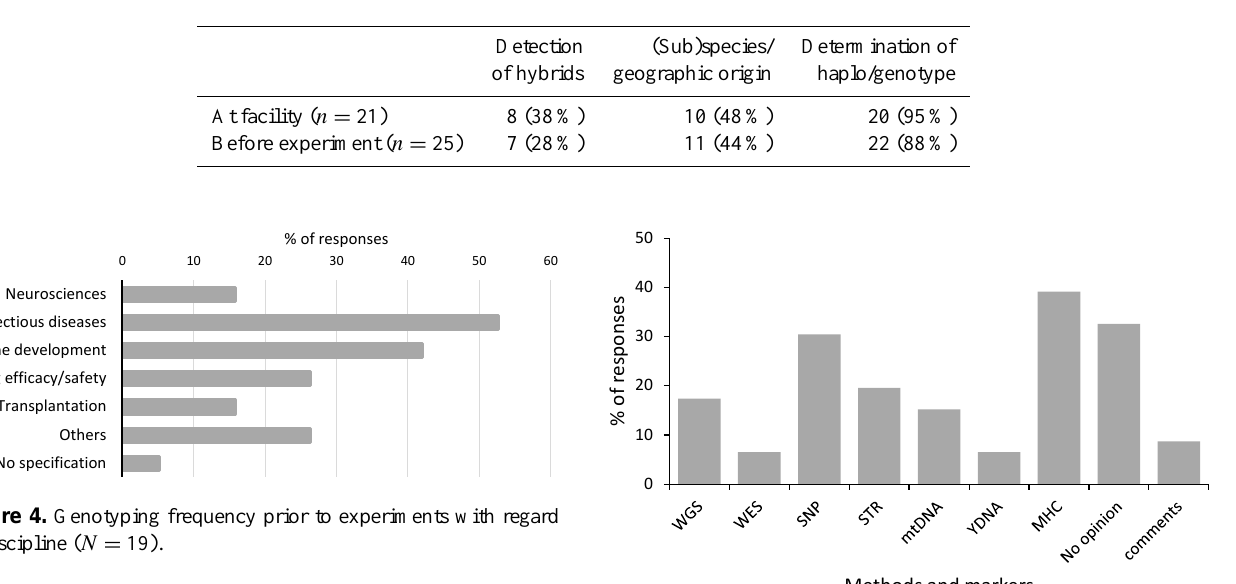
Table 2. Objectives for conducting genotyping at represented facilities in general (“at facility”) and prior to experiments (“before experi- ments”). N corresponds only to the number of respondents that conducted genotyping.